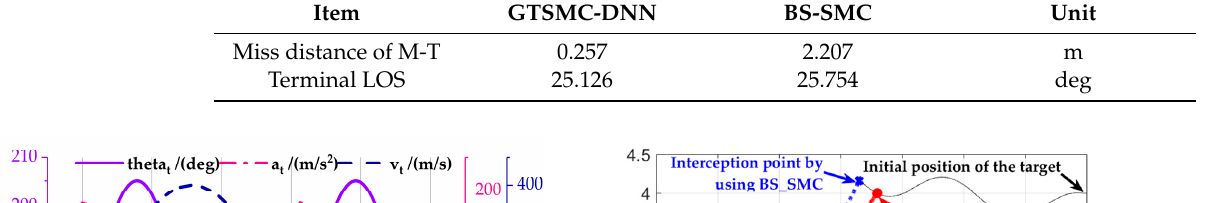
Figure 9. ( a ) The maneuver characteristics of the target; ( b ) The missile-target pursuit trajectory.